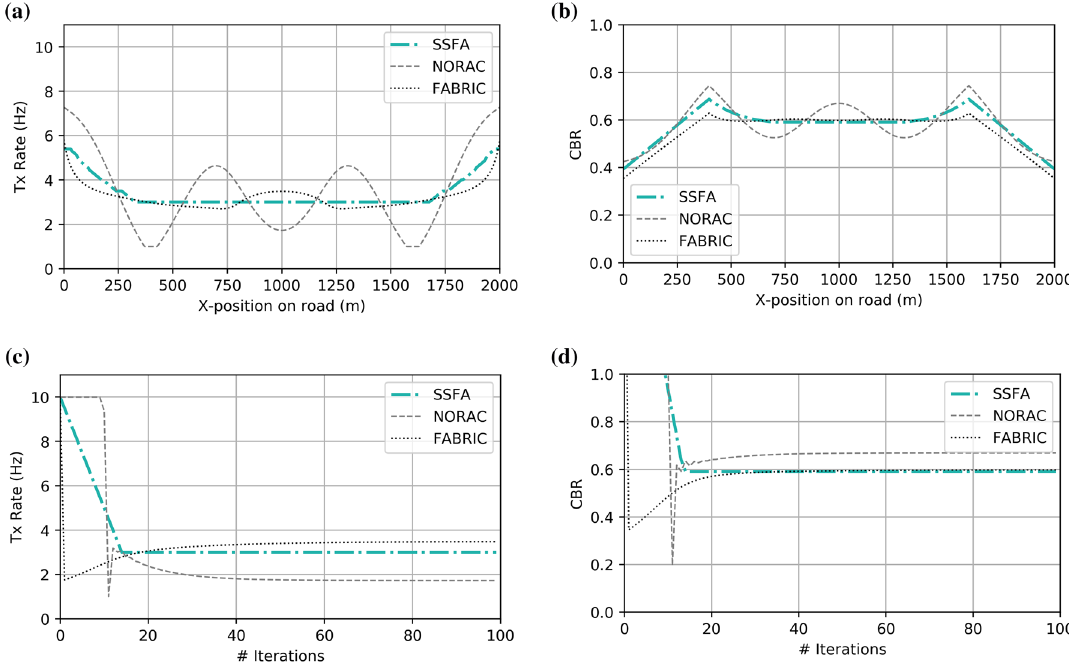
Figure 3. Theoretical comparison (implemented in Python) of the proposed congestion control approach with FABRIC and NORAC. ( a ) Recommended beaconing rate and ( b ) CBR measured for a row of vehicles versus their position on the road; ( c ) Evolution of the beaconing rate and ( d ) CBR of a vehicle located in the middle area of the road over time.